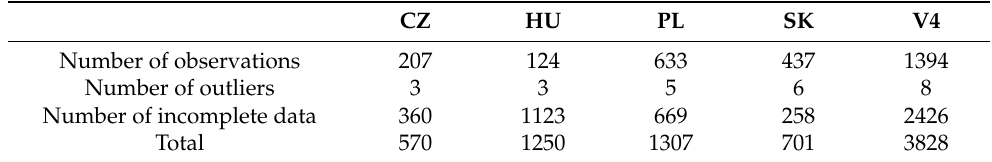
Table 5. Final sample.